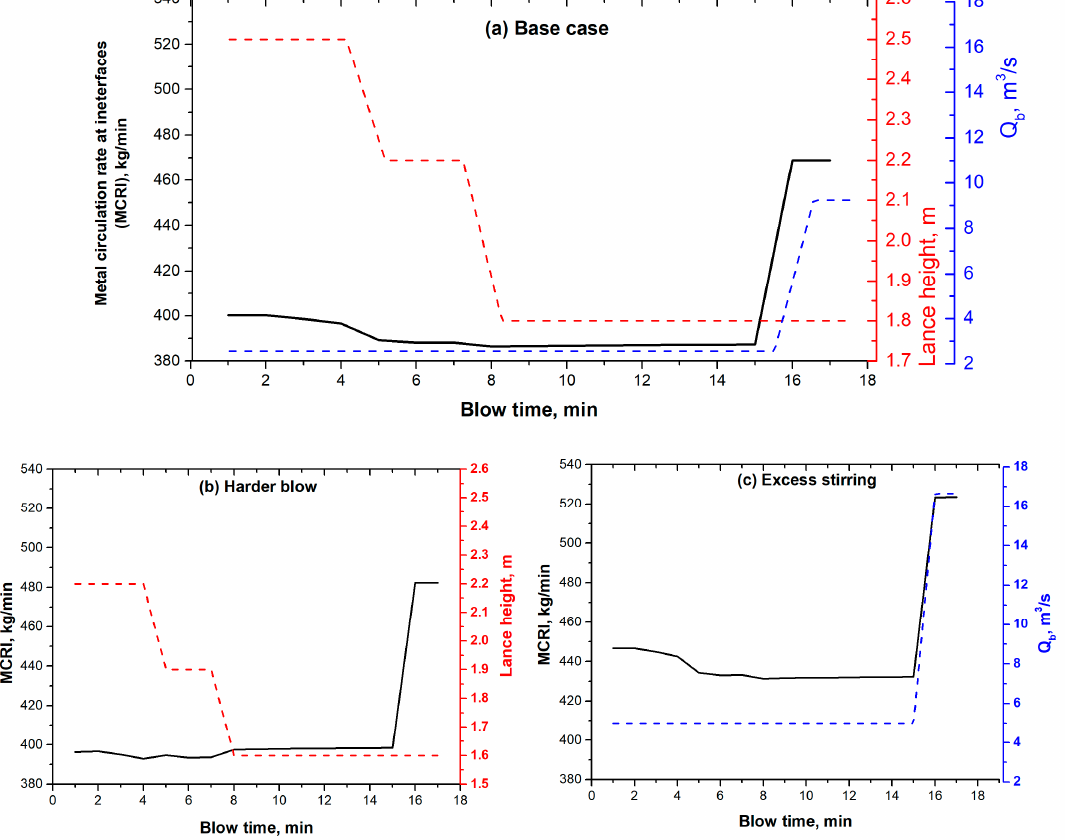
Figure 7. Effect of lance height and stirring rate on metal circulated at cavities and slag-metal bulk. ( a ) Base case (for operation of Cicutti et al., ( b ) Harder blow i.e., consistently lower lance height (2.2 m/1.9 m/1.6 m), ( c ) Excess stirring rate: 5 m 3 /s (0–15 min), 16.66 m 3 /s (16–17 min).